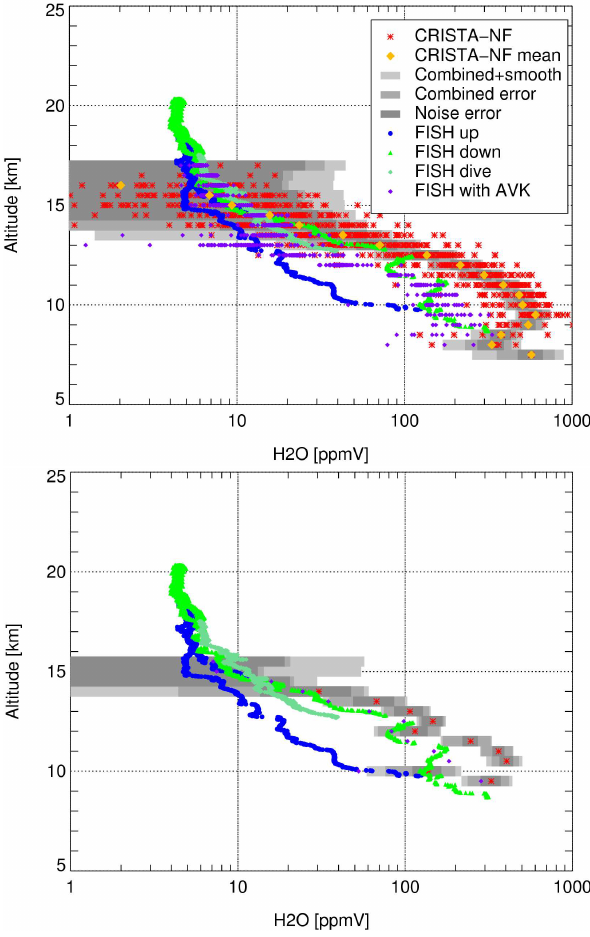
Fig. 10. CRISTA-NF and FISH H 2 O during flight L5 shown for all profiles (a) and profile